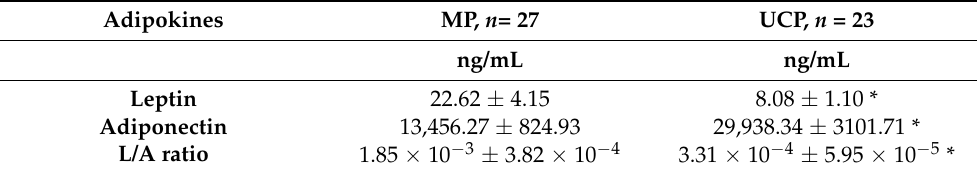
Table 4. Adipokine levels in maternal and umbilical cord plasma.